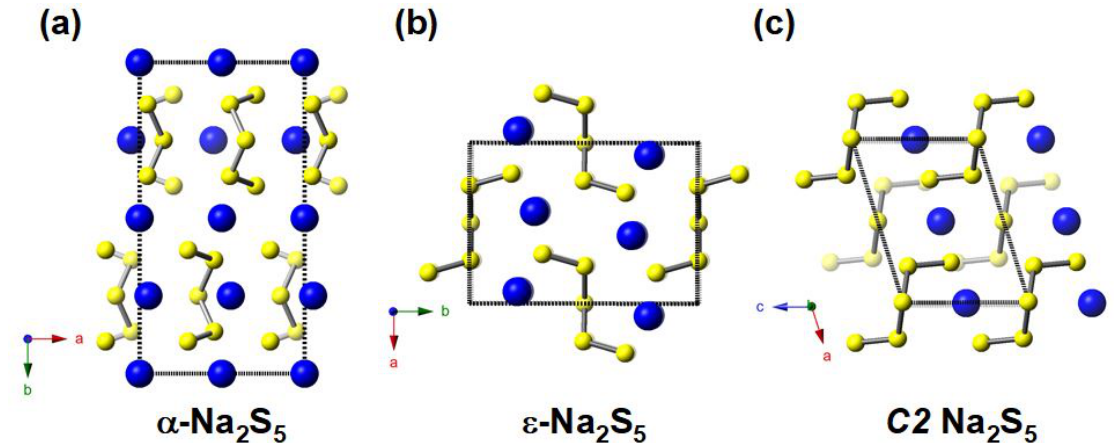
Figure 2. Unit cells of the previously known ( a ) α -Na 2 S 5 [11] and ( b ) (cid:101) -Na 2 S 5 [20] polymorphs, as well as the newly predicted ( c ) C 2-Na 2 S 5 structure. Sodium atoms are colored blue, and sulfur atoms are